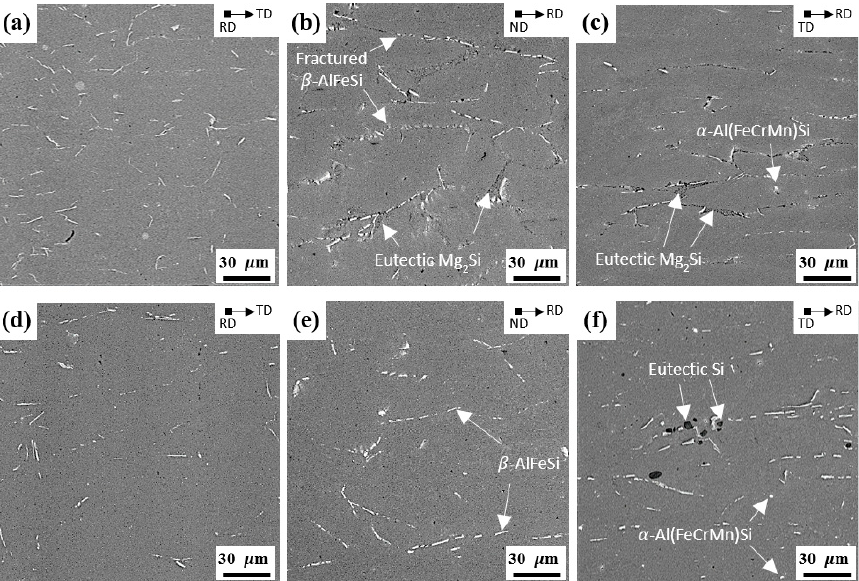
Figure 3. SEM images of ( a – c ) NH and ( d – f ) NL alloys with a thickness of 5.6 mm before cold rolling: ( a , d ) RD, ( b , e ) ND, and ( c , f ) TD.